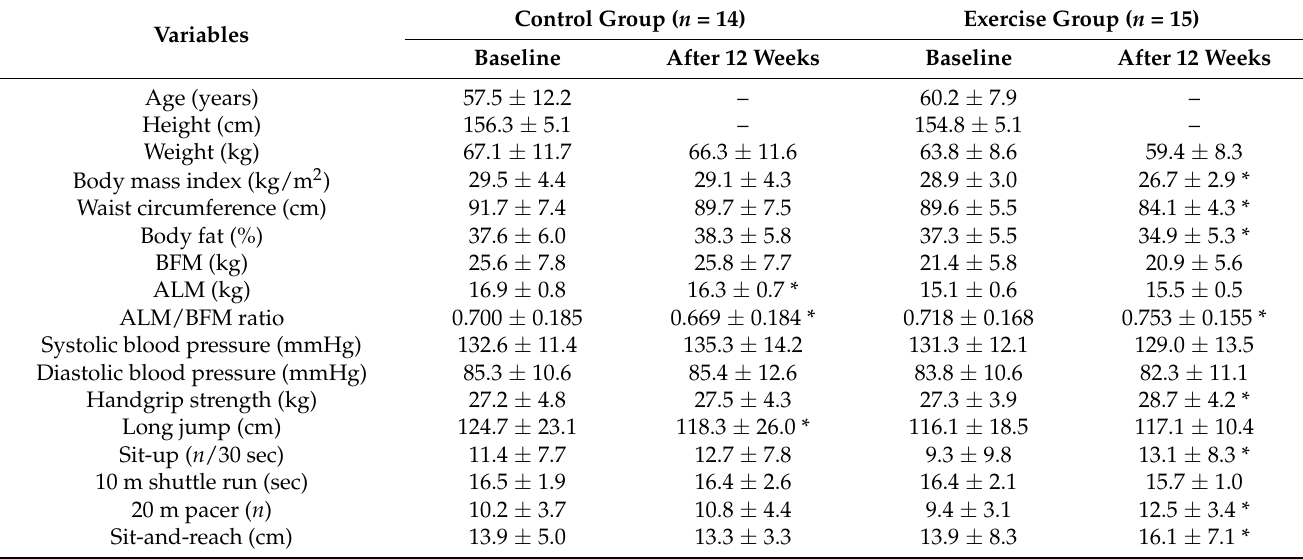
Table 1. Changes in kinanthropometric parameters from baseline to 12